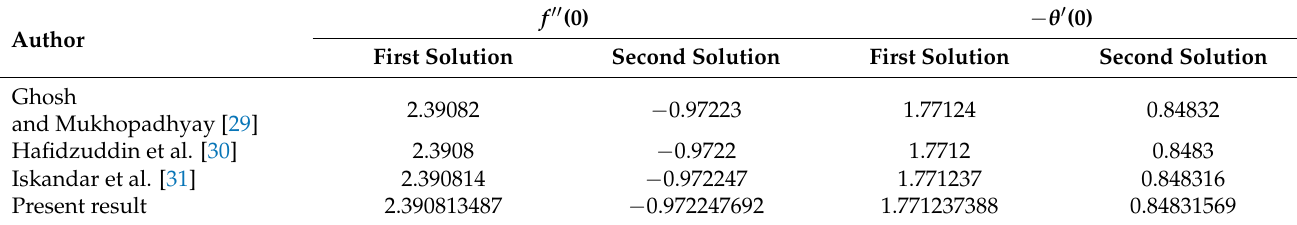
Table 3. Comparison of several of numerical results for f ”(0) and − θ (cid:48) (0) ( λ = 1, S = 3, Pr = 0.7).